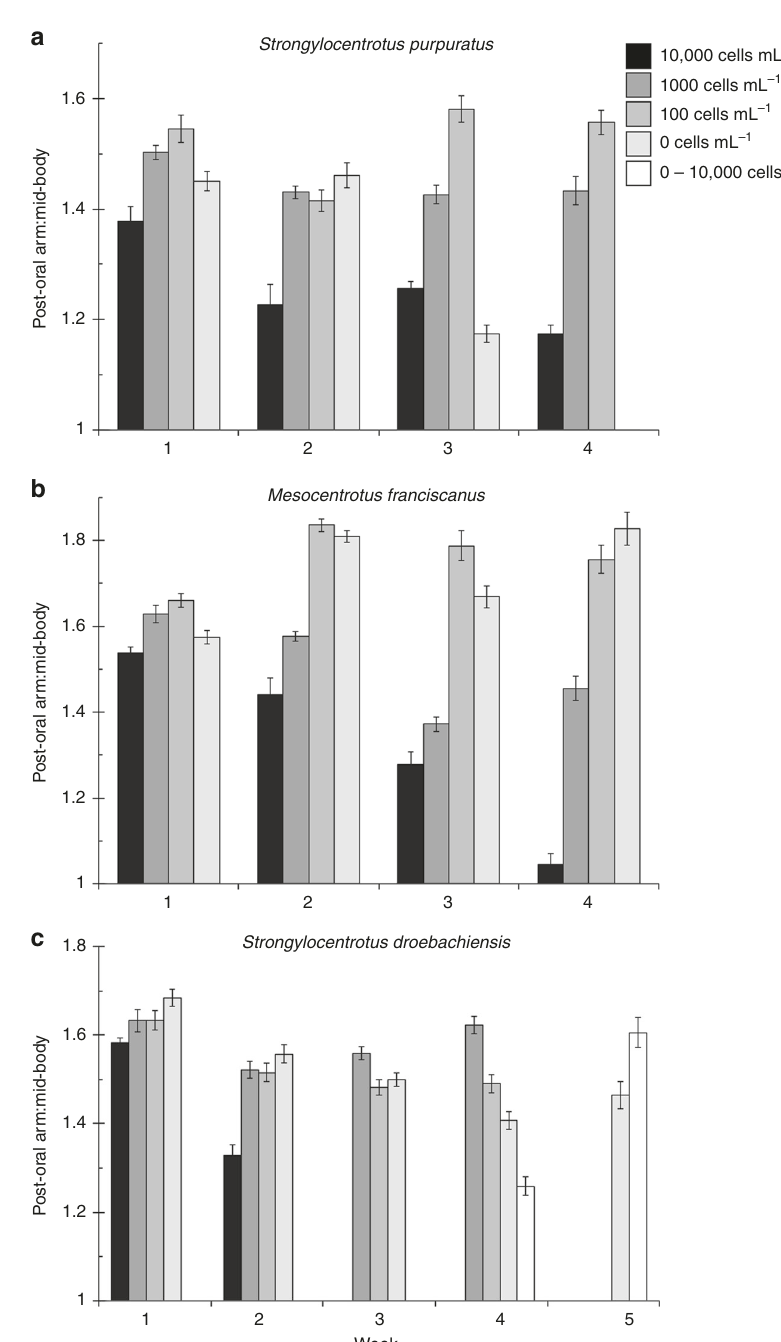
Fig. 1 Three species of echinoid larvae alter phenotype to feeding environment. Ratio between the post-oral arm and mid-body line (mean ± standard error; n = 20; Supplementary Fig. 1D) for Strongylocentrotus purpuratus ( a ), Mesocentrotus franciscanus ( b ), and S. droebachiensis ( c ) larvae having been fed either 10,000 (black), 1000 (dark gray), 100 (gray), and 0 cells mL − 1 (light gray). For S. droebachiensis , larval phenotype was also manipulated (white) by being fed 0 cells mL − 1 for 3 weeks, then transferred to 10,000 cells mL − 1 for 3 weeks (i.e., until